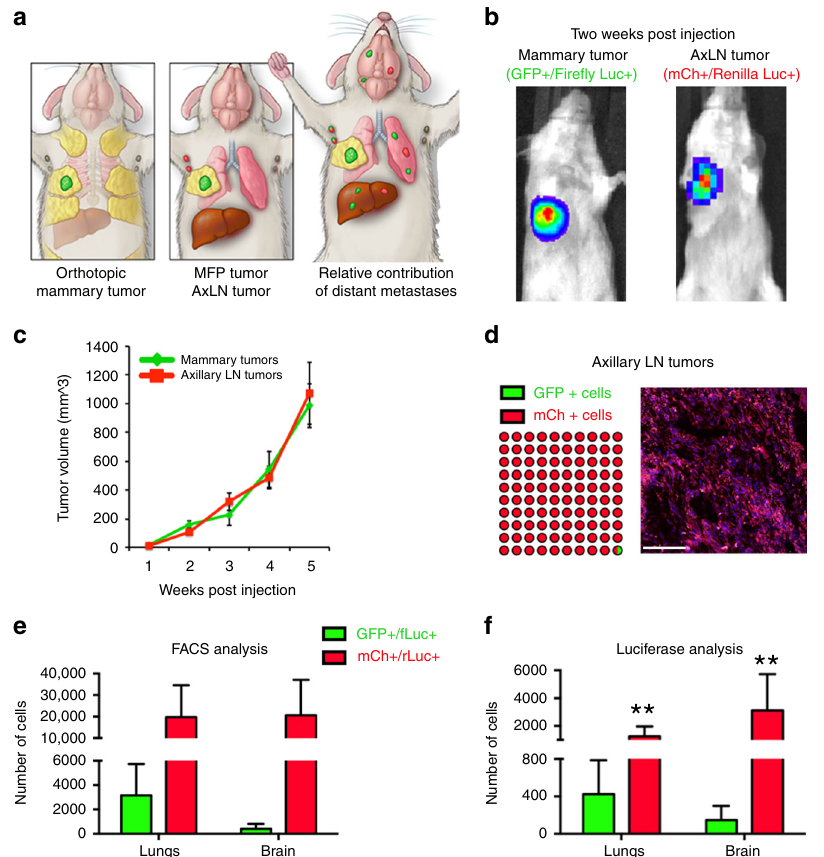
Fig. 2 AxLN-micro-injected tumors metastasize ef fi ciently to distant tissues. a Schematic depicting the injection and expected outcomes of GFP/fL- or mCh/rL-labeled 4T1 cells into the MFP or AxLNs, respectively, of the same mouse. b Representative IVIS imaging of GFP/fL and mCh/rL cells post injection in the same mouse. c Caliper measurements of tumor growth for MFP and AxLN tumors ( n = 7 mice). d Fluorescence imaging of post-injected AxLNs after 6 weeks of growth show minimal GFP + cells. e Flow cytometry quanti fi cation of lungs and brains to determine relative metastatic capability of tumors simultaneously established in MFPs and AxLNs. f Ex vivo luciferase signal observed in lungs and brains of mice simultaneously bearing GFP/fL MFP tumors and mCh/rL AxLN tumors. Statistical signi fi cance was measured by Mann – Whitney t tests; ** p <